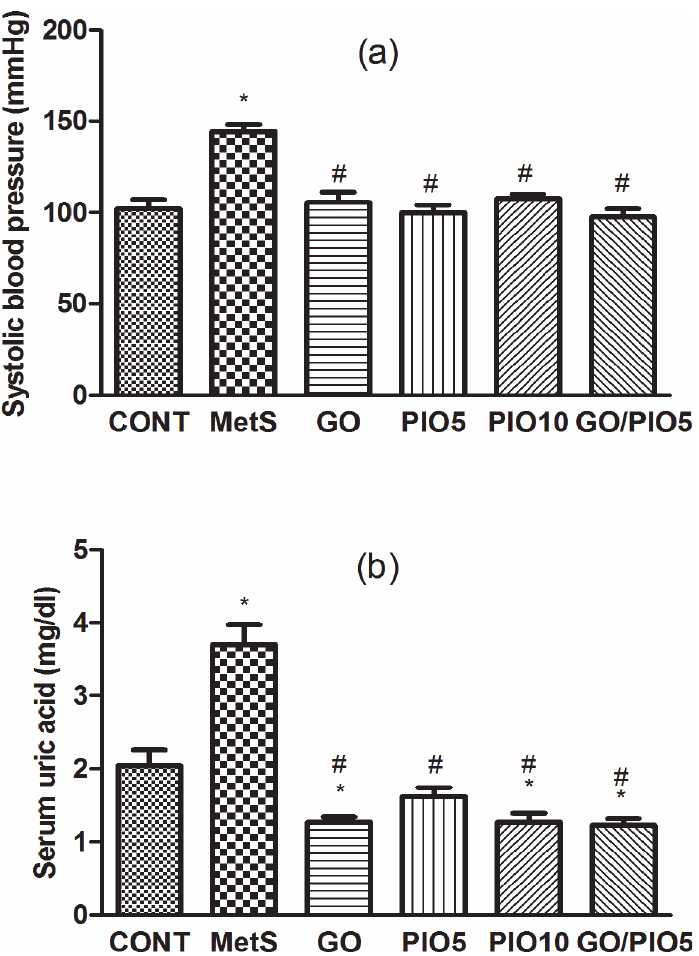
Fig 4. Effect of 4 weeks daily oral administration of geraniol (GO; 250 mg/kg), pioglitazone (PIO; 5 and10 mg/kg), and GO with PIO5 on (a) systolic blood pressure and (b) serum uric acid level in fructose-induced metabolic syndrome (MetS) in rats. Values are mean (6 – 8 animals) ± SEM. P < 0.05, as compared to control (CONT) ( * ) and MetS ( # ) groups using one-way ANOVA followed by Tukey – Kramer